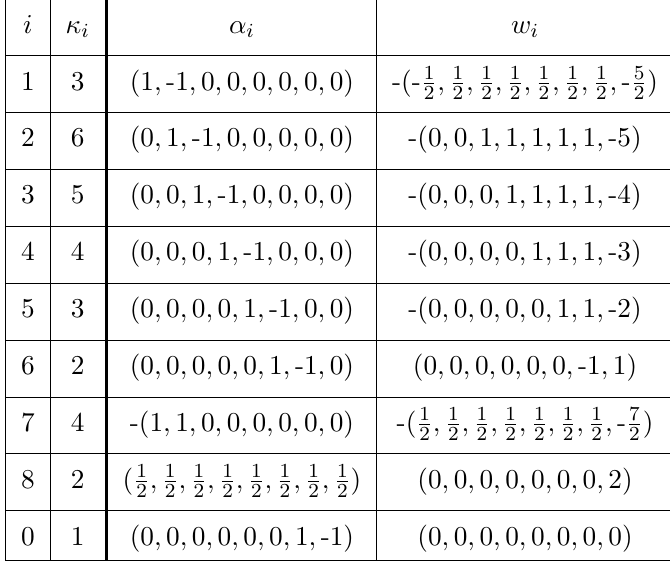
Table 2 . Simple roots α i , Kac marks κ i and fundamental weights w i of E 8